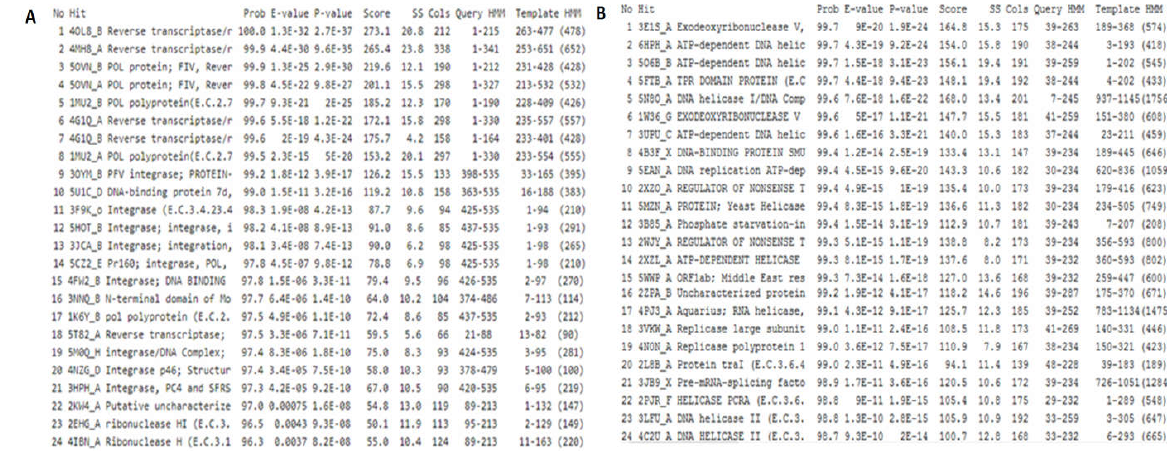
Fig.2 HHpred output displaying probable similarities of two HPs: A) LOC105974023 and B) LOC109219975 Three-dimensional